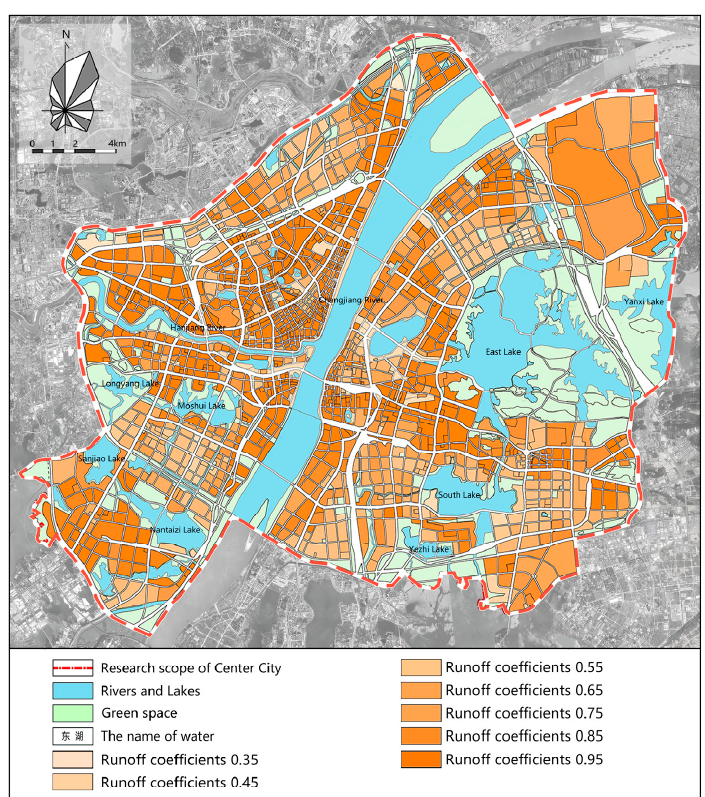
Figure 13. Runoff coefficients of downtown Wuhan.